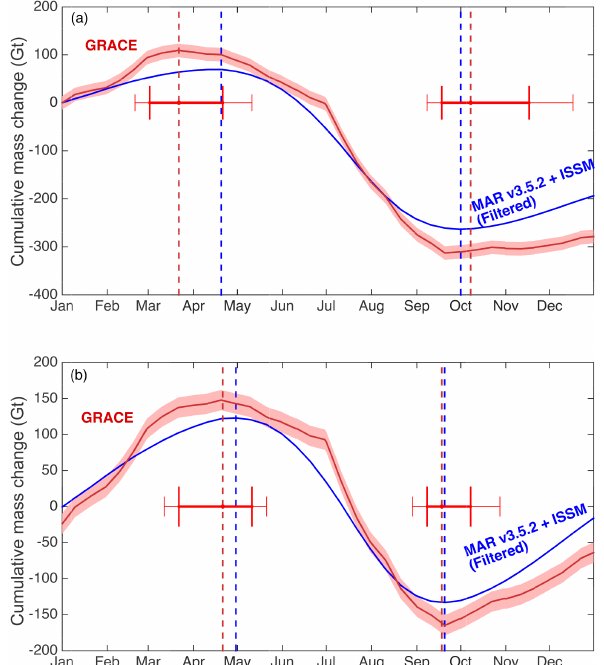
Figure 8. (a) The mean January 2003–December 2012 seasonal cy- cle of GrIS cumulative mass change from GRACE-LM and MAR v3.5.2 + ISSM. (b) The same as (a) for the case when the time series from all mascons are